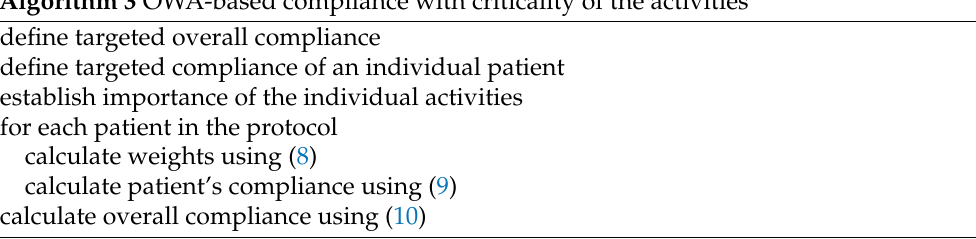
Algorithm 3 OWA-based compliance with criticality of the